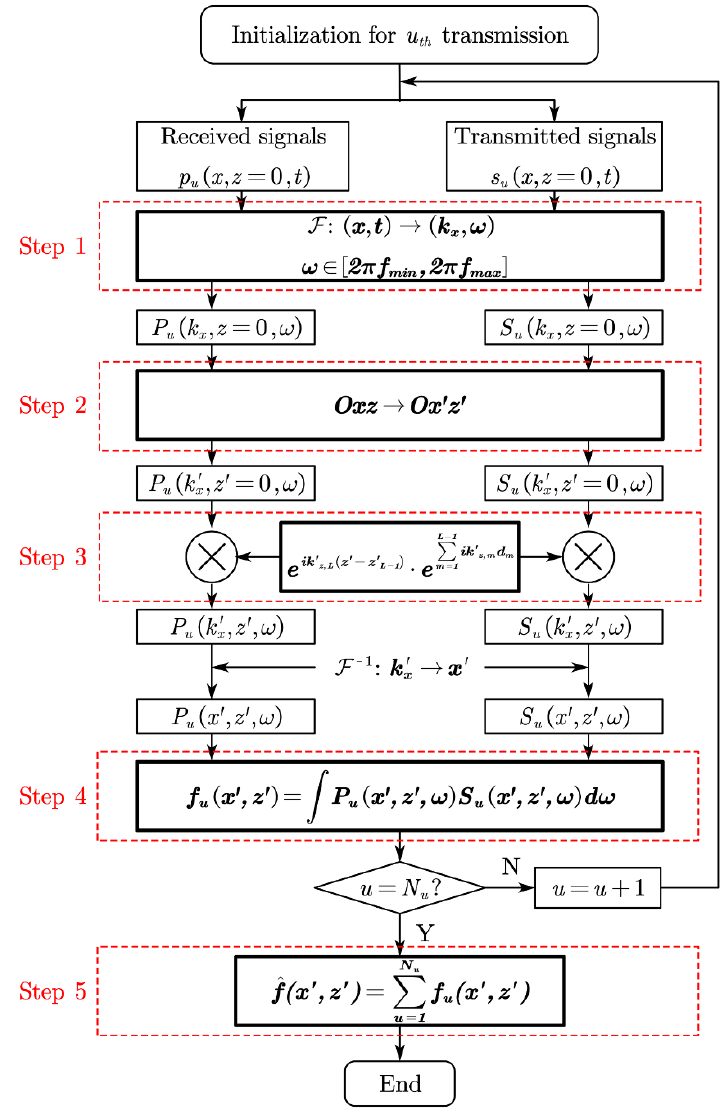
Figure 3. The flowchart of the proposed